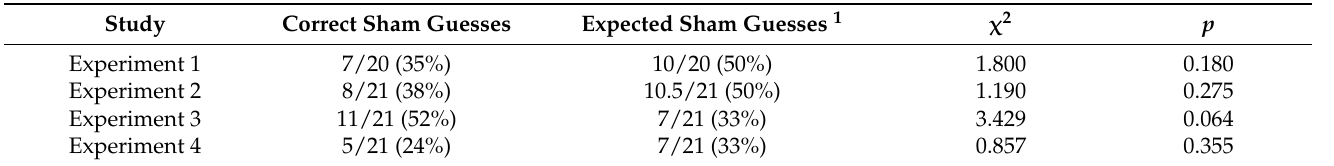
Table 2. The proportions of participants who accurately guessed the sham condition and the results of the chi-square test.